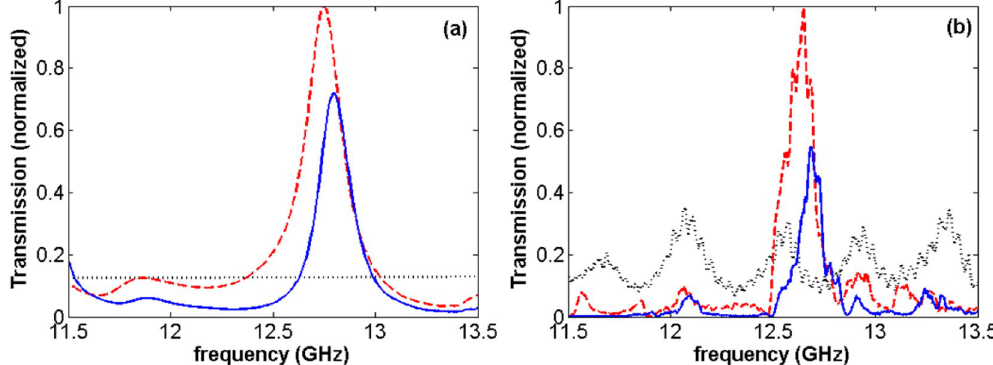
Figure 2. Numerical transmissions calculated for a bare aperture (dotted-black), ZIM/A structure (dashed- red), and ZIM / A / ZIM system (solid-blue) for Δ ∼ 2 mm . The experimental results are represented in panel (b),